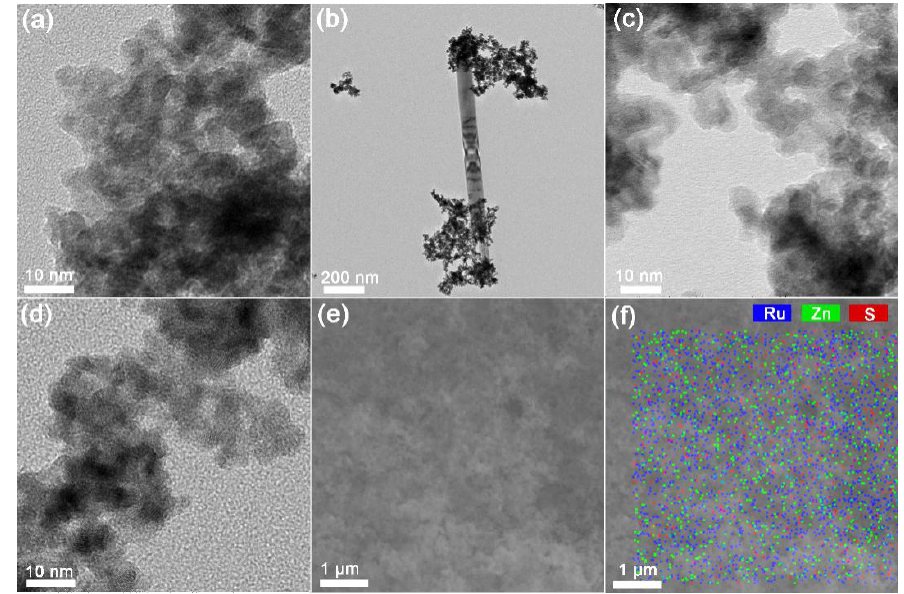
Figure 3. TEM images of the Ru-4.7 catalysts for selective hydrogenation of benzene to cyclohexene with different additives after catalytic experiments. ( a ) Blank; ( b ) ZnO; ( c ) ZnSO 4 ; ( d ) ZnO and ZnSO 4 ; ( e ) SEM image and ( f ) element mapping image of Ru-4.7 catalyst after catalytic experiments in the presence of both ZnO and ZnSO 4 .